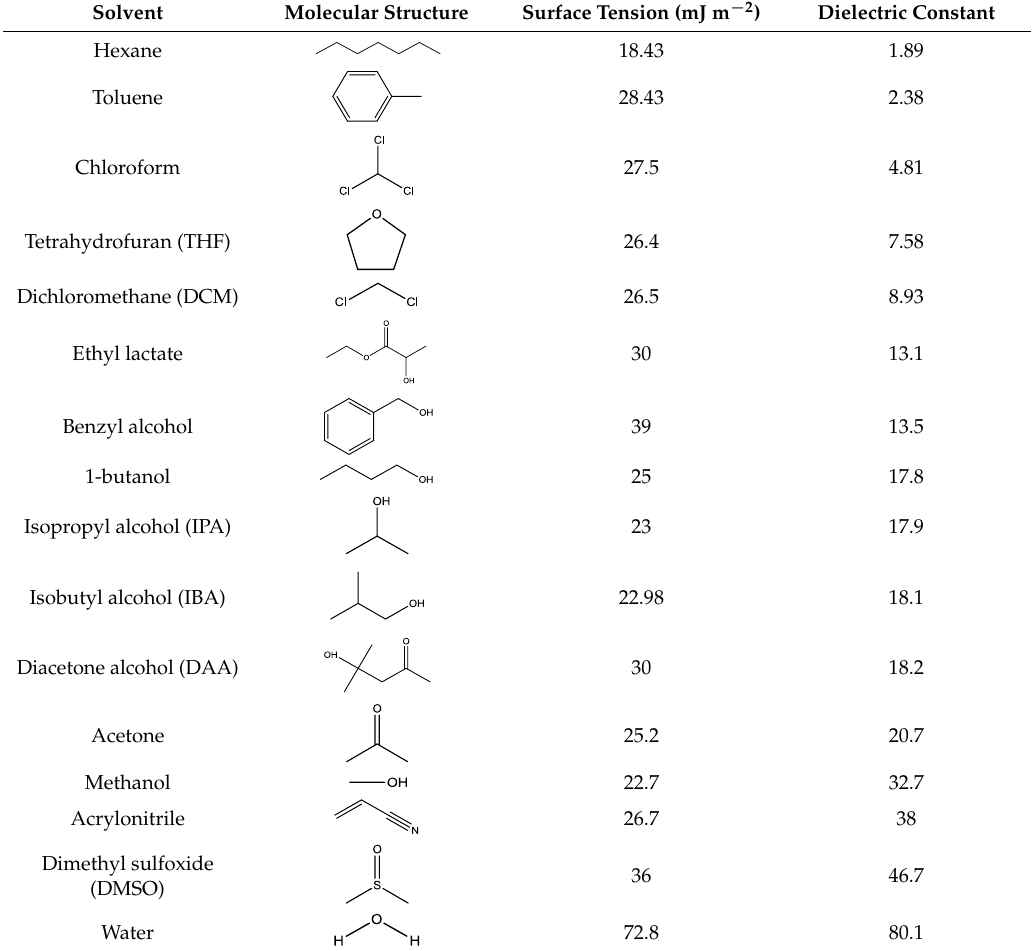
Table 1. Molecular structure, surface tension, and dielectric constant of the 16 selected solvents.